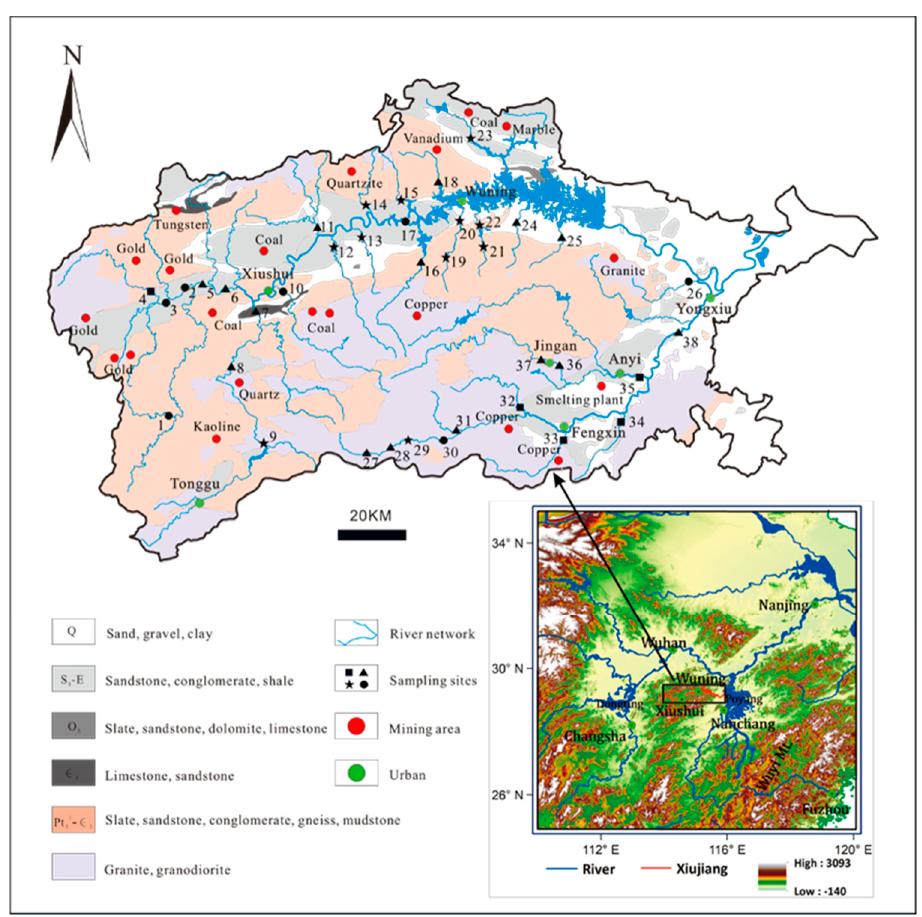
Figure 1. Simplified map showing the geology and sampling sites in the Xiujiang River.